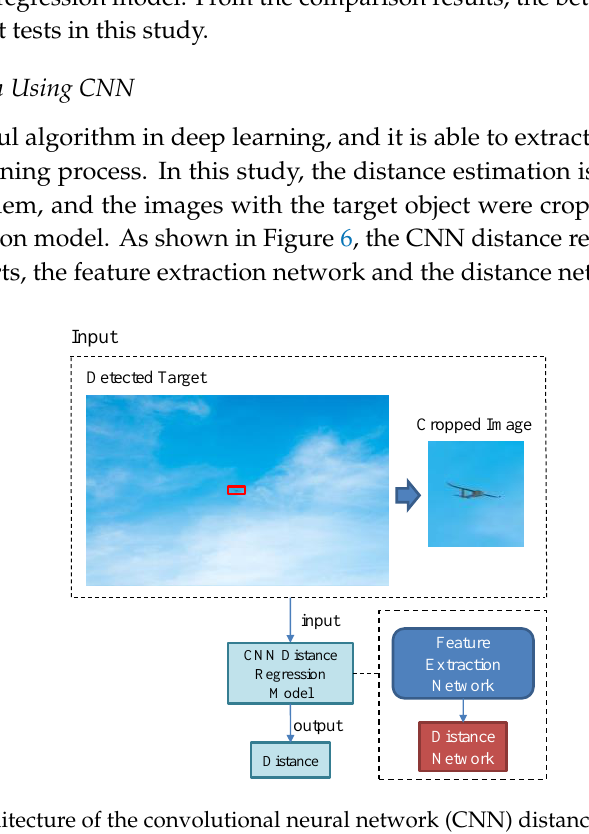
Figure 2. Synthetic image made by Blender.